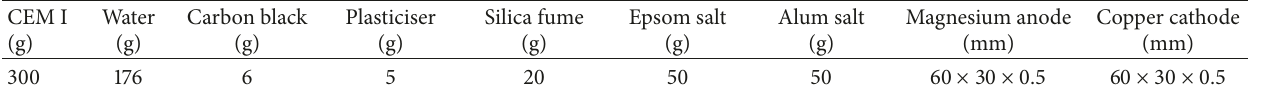
Table 5: Final battery design.